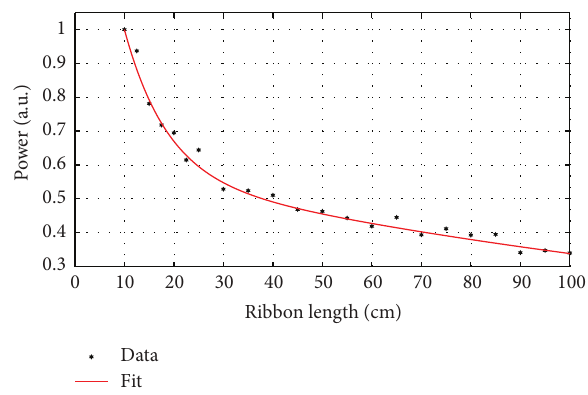
Figure 5: Plot of the data and the best fit relative to attenuation length measurement by coaxial laser injection. Table 1: Extrapolated parameters: cut fiber. Parameters Values 𝑎